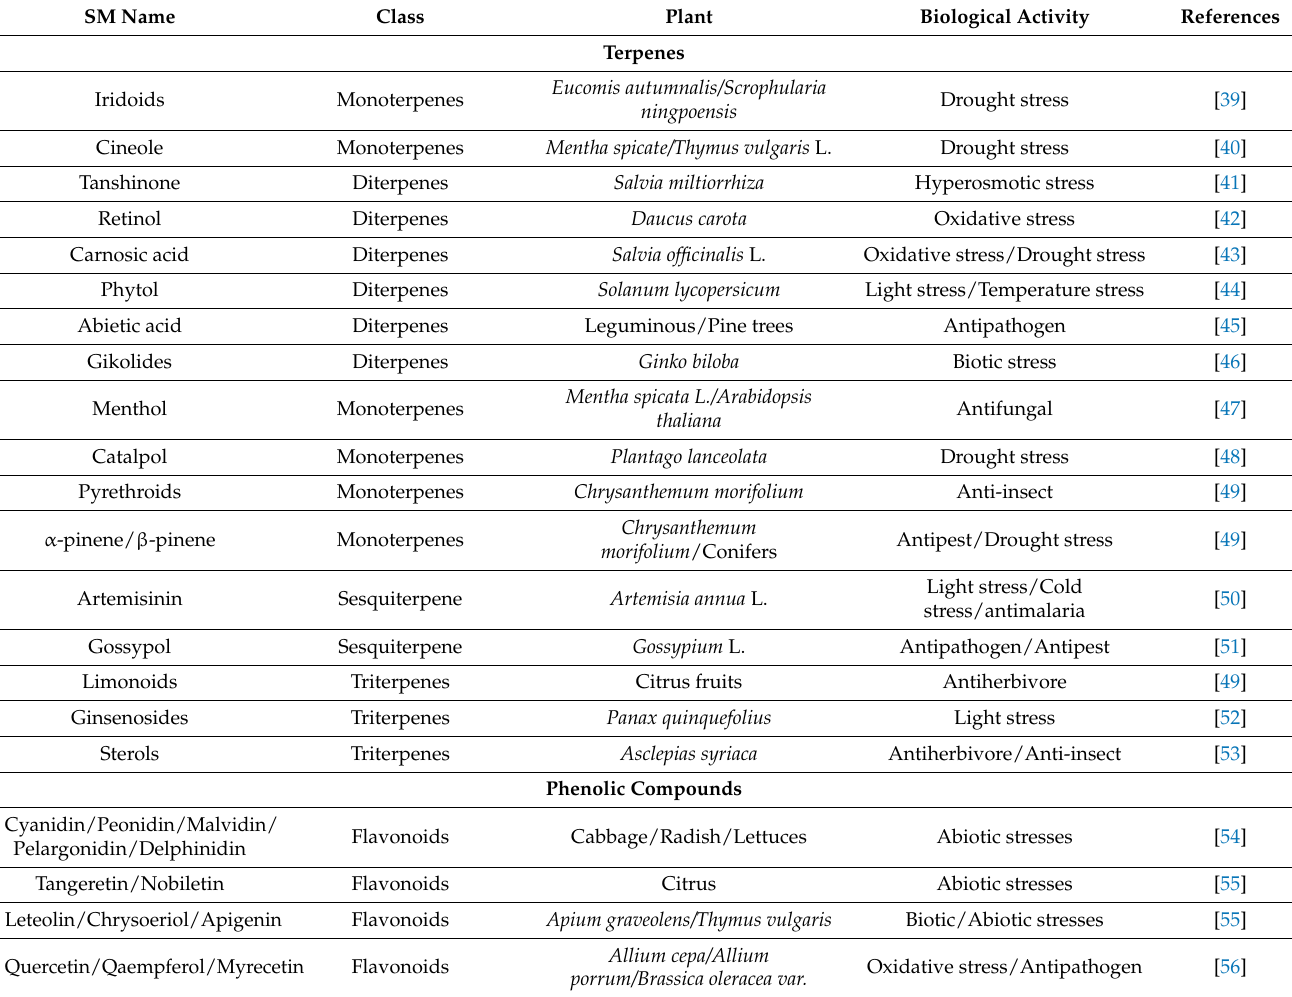
Table 1. The occurrence and biological activities of secondary metabolites (SMs) in various plant